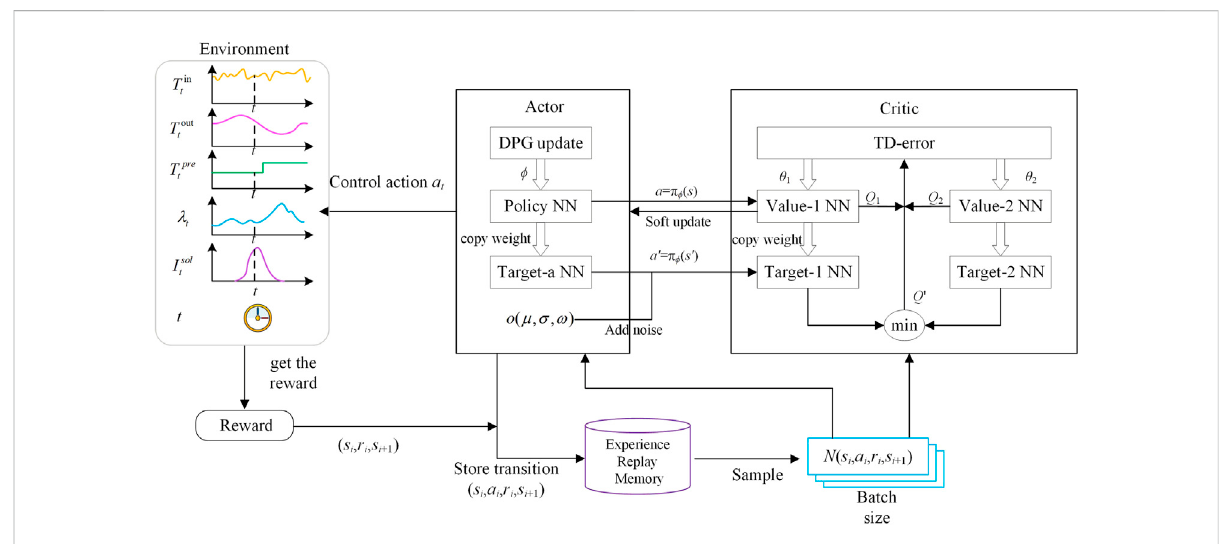
FIGURE 4 Framework of TD3-based DRL